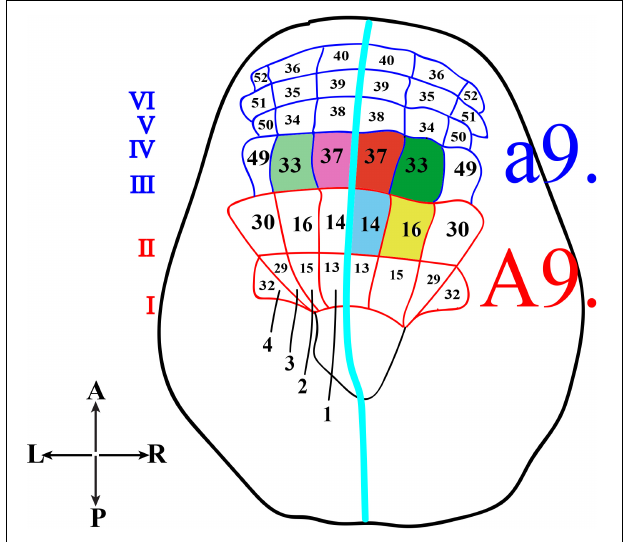
FIGURE 2 | Schematic representation of Ciona neural plate stage. Neural plate, dorsal view, with 4 columns (1–4) and six rows (I-VI). The turquoise line separates the two bilaterally symmetrical blastomere pairs. The former a9-lineage photoreceptor cell precursors, right a9.33 and a9.37, are in green and red, respectively, while the supposed precursors of coronet cells, left a9.33 and a9.37, are in light green and light pink. The current A9-lineage Group I and II (A9.14) photoreceptor cell precursors is indicated in blue and Group III (A9.16) photoreceptor cell precursors in